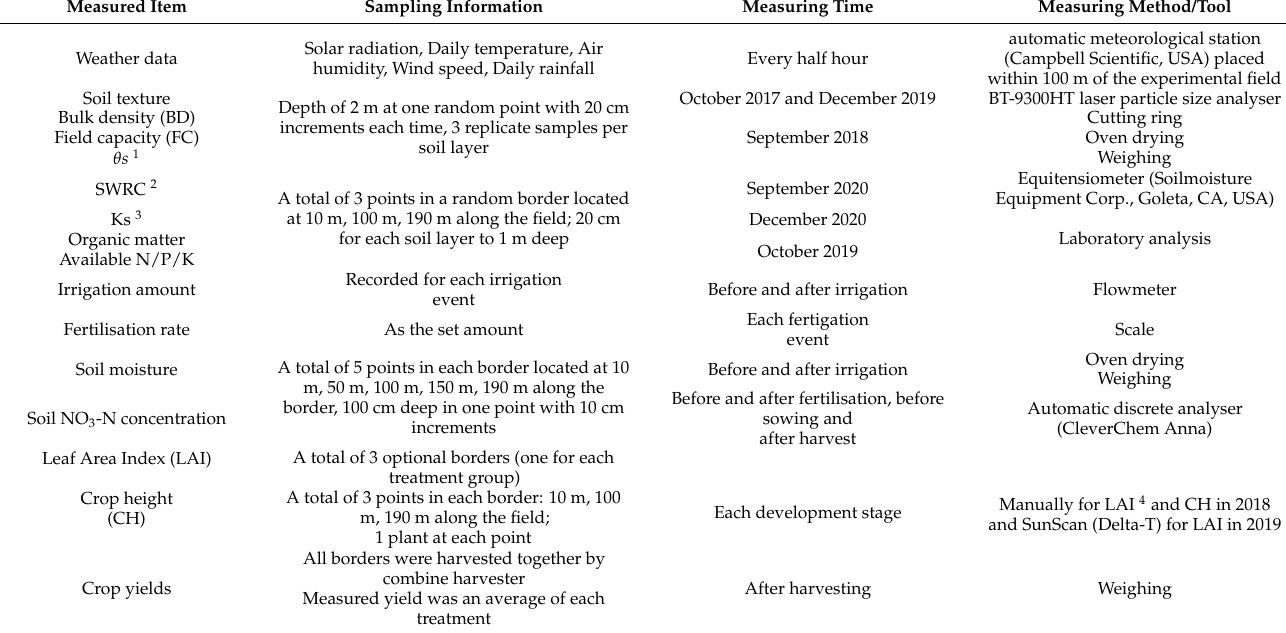
Table A1. Detailed Field Observations and Data Measurements.